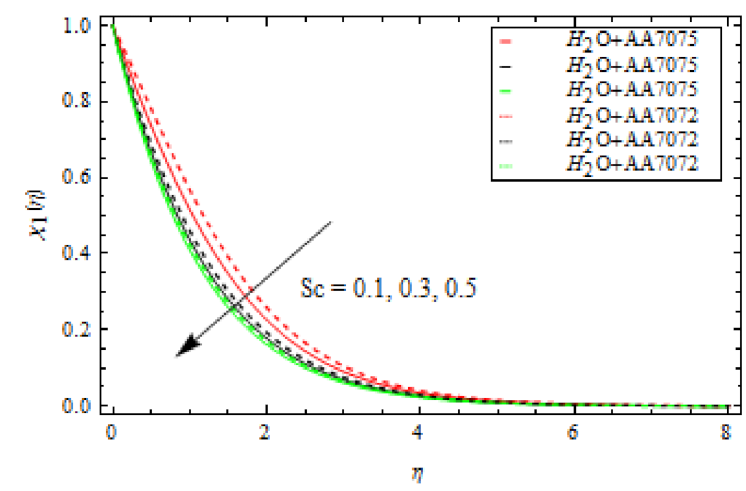
Figure 14. Influence of Schmidt number Sc on concentration profile.